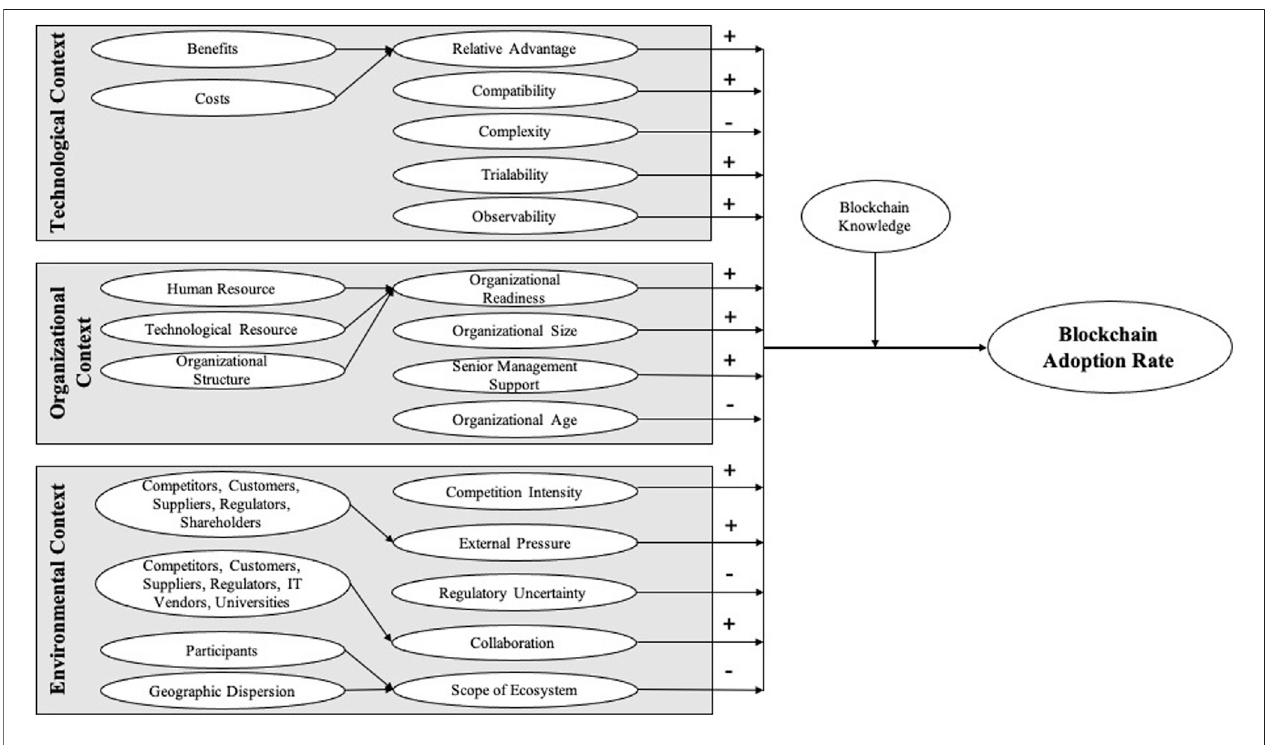
FIGURE 1 | The blockchain adoption model (BAM).